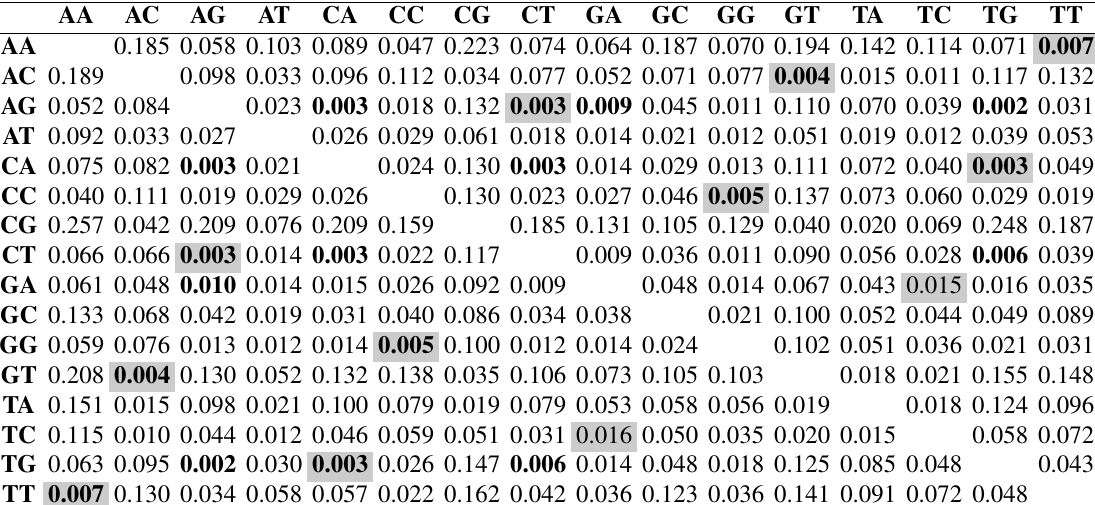
Table 2: Kullbak-Leibler divergence between the 16 dinucleotides in the protein-coding distance distribution. The highlighted values in grey correspond to reversed complement dinucleotide pairs and the values highlighted in bold correspond to dinucleotide pairs with divergence below 10 (cid:0) 2